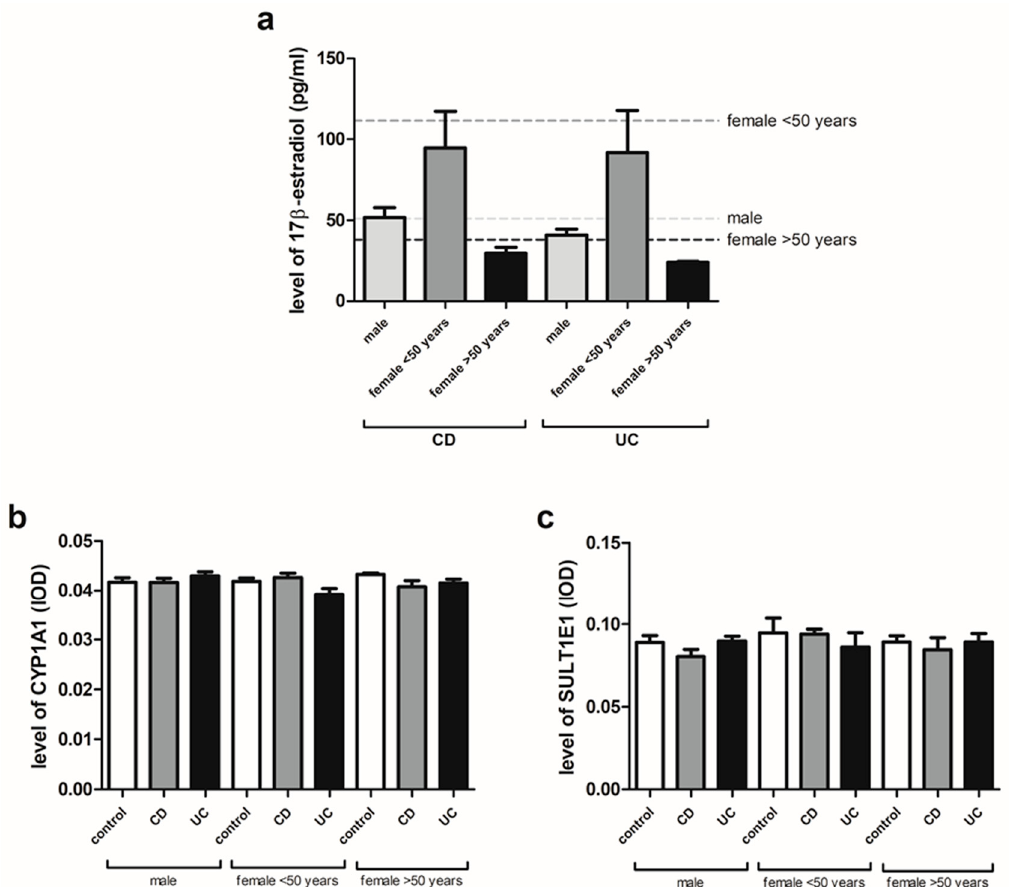
Figure 1. Serum 17 β -estradiol ( a ), CYP1A1 ( b ) and SULT1E1 ( c ) levels in CD and UC patients and related controls: males (control, n = 12; CD, n = 19; UC, n = 24), females under the age of 50 years (control, n = 9; CD, n = 7; UC, n = 12) and females over the age of 50 years (control, n = 10; CD, n = 5; UC, n = 6). Dotted lines represent reference values. Values are means ± SEM.